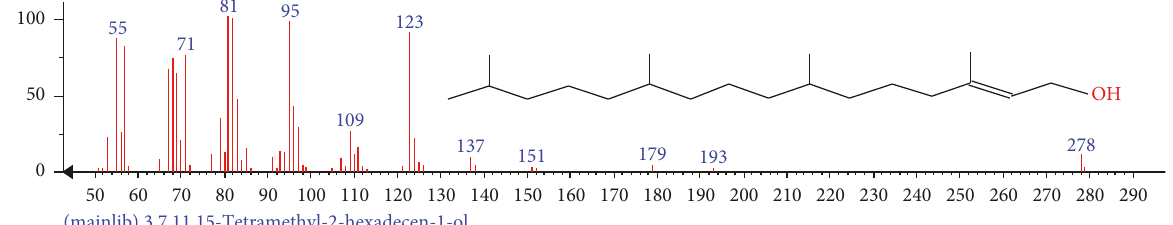
3,7,11,15-Tetramethyl-2-hexadecen-1-ol50 60 70 80 90 100 110 120 130 140 150 160 170 180 190 200 210 220 230 240 250 260 270 280 (mainlib) Figure 31: Mass spectrum of compound 3,7,11,15-tetramethyl-2-hexadecen-1-ol of whole plant hexane fraction of Achillea wilhelmsii (WHFAW).